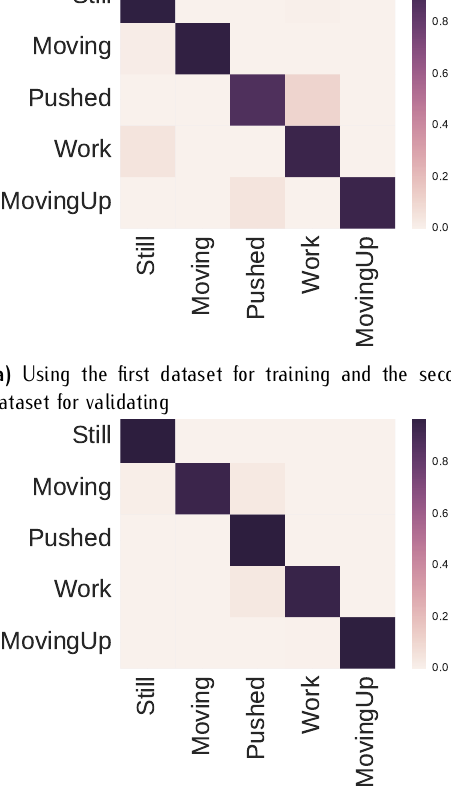
Figure 6. Confusion matrices of the models built with the manually selected